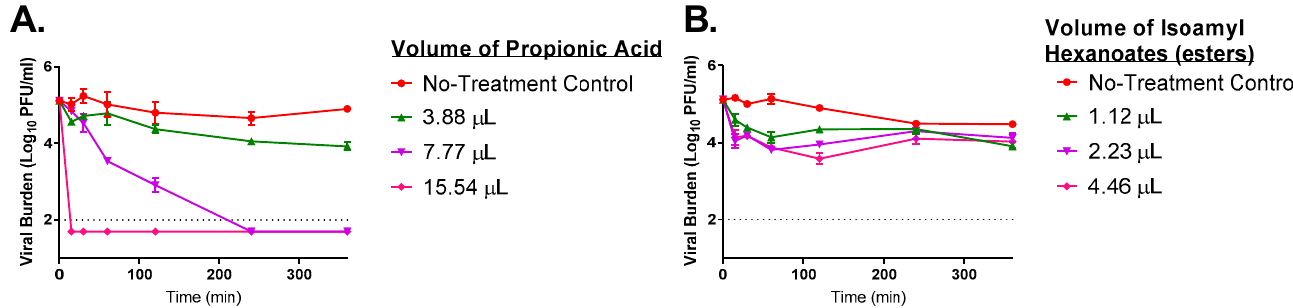
Figure 5. The antiviral effect of various volumes of the individual components of the Propylamylatin formula, propionic acid ( A ) and isoamyl hexanoates ( B ). The volumes evaluated correspond to the amount of that component present in a 5, 10, or 20 µ L volume of Propylamylatin™, as acid to esters exist in a ratio 7:2 ( v/v ) in the Propylamylatin formula combination. A 1 mL suspension of 10 5 PFU of SARS-CoV-2 was directly exposed to various volumes of propionic acid or isoamyl hexanoates and incubated at 37 ◦ C. At various times post-exposure, viral suspensions were harvested, and viral burden was quantified by plaque assay in Vero E6 cells. Viral burden is reported as log 10 PFU/mL. Data points correspond to the geometric mean of two independent samples and error bars represent one standard deviation. The horizontal dashed line signifies the plaque assay limit of detection.